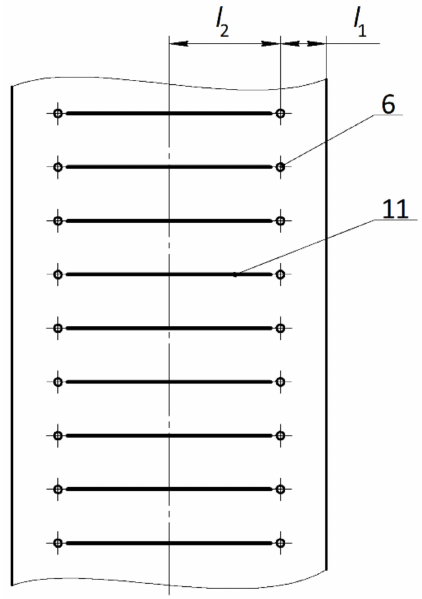
Figure 4. Unfolded drawing of the bearing surface with